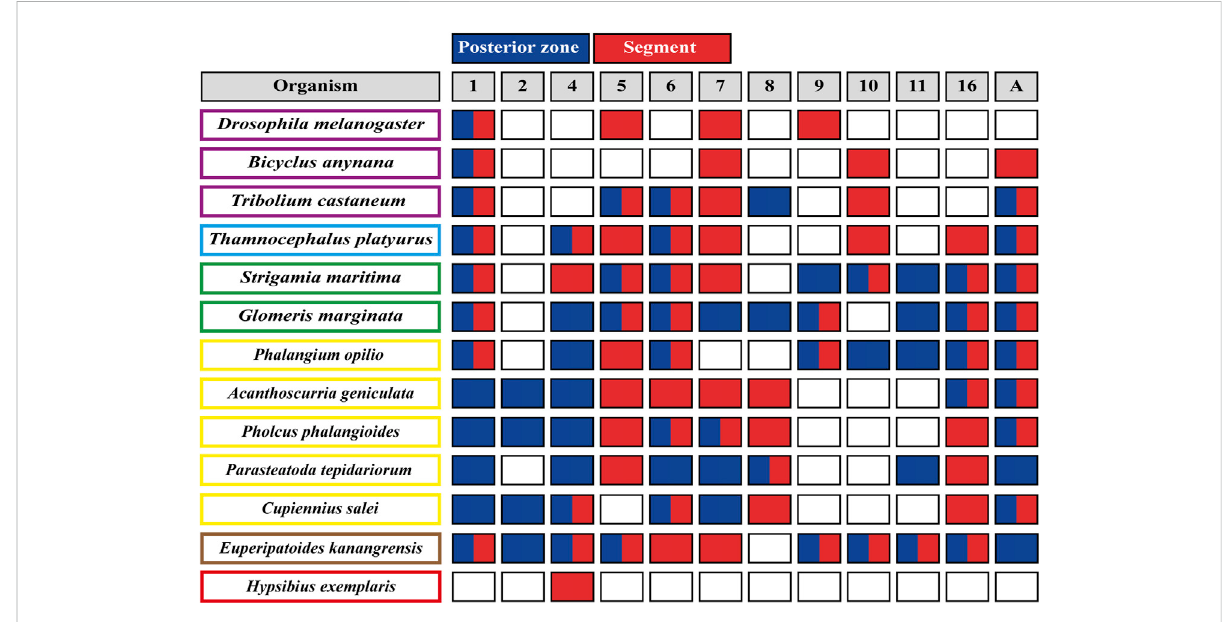
FIGURE 3 Wnt ligandsexpressiondomainswithin panarthropod germbands. Bluesboxes represent theexpression ofthecorresponding Wnt ligandinthe posterior zone, red boxes indicate segmental expression, and white boxes show the absence of expression.Double red and blue boxes indicate Wnt ligand expression at the posterior zone and within segments. Insects are shown in purple rectangles, crustaceans in pale blue, myriapods in green, chelicerates in yellow, onychophoran in brown and tardigrades in red. The Wnt ligand families are indicated at the top, in gray boxes. D. melanogaster (Muratet al.,2010); B.anynana (Holzem etal., 2019); T.castaneum (Bolognesi etal.,2008a); T. platyurus (Constantinouetal., 2016); S. marítima (Hayden and Arthur, 2014); G. marginata (Janssen et al., 2010; Janssen and Posnien, 2014); chelicerates (Janssen et al., 2021; Janssen and Eriksson, 2022); E. kanangrensis (Hogvall et al., 2014); H. exemplaris (Chavarria et al.,